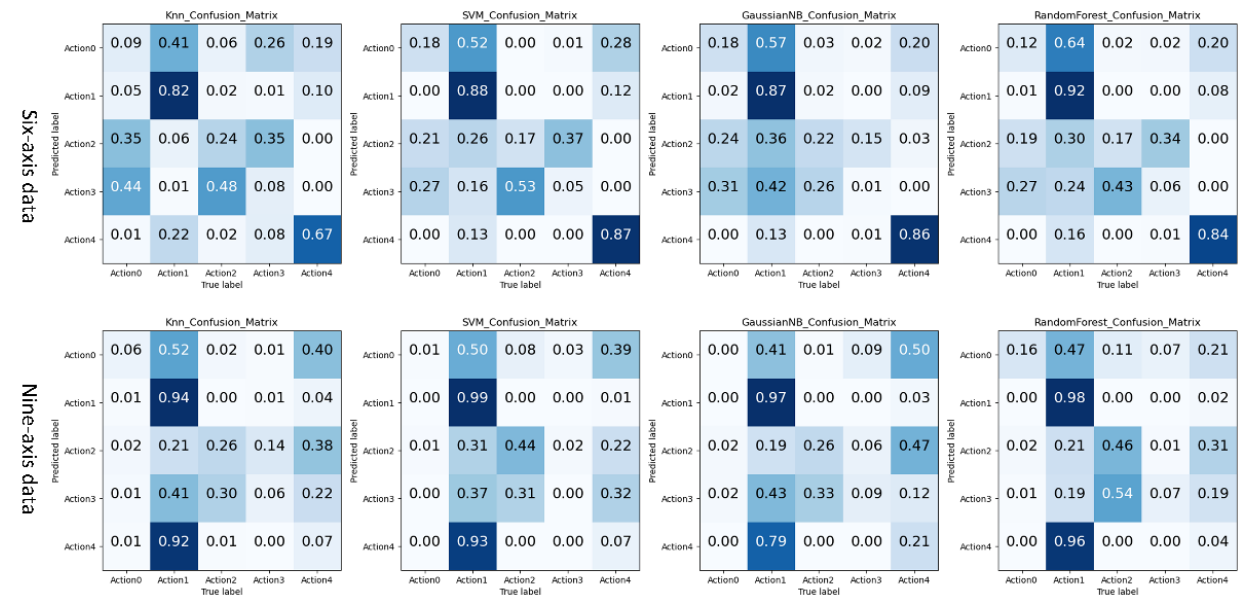
Figure 12. The recognition accuracy of traditional machine learning models based on artificial features on non-professional test sets.